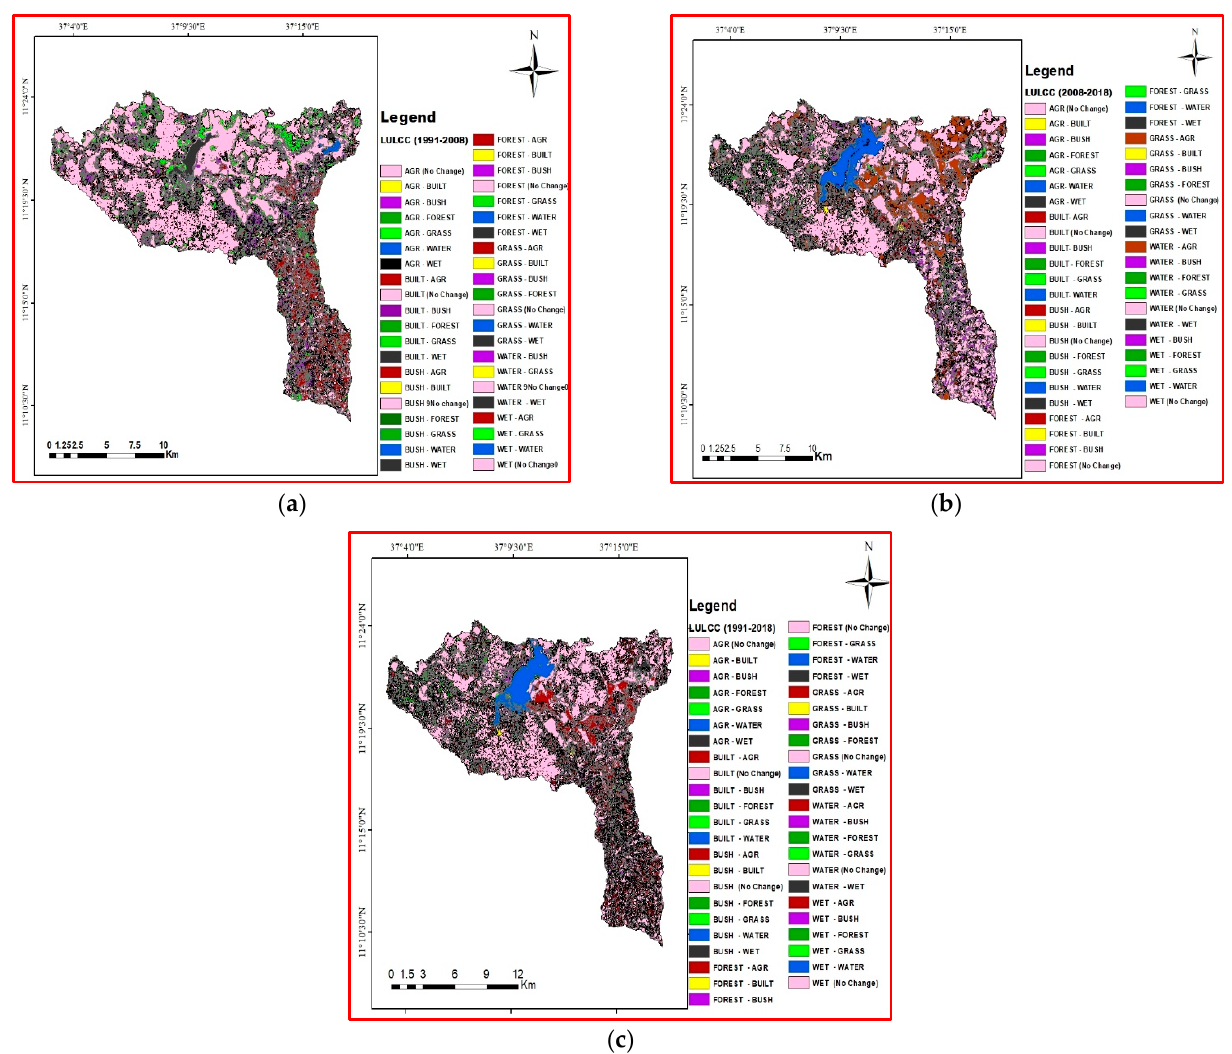
Figure 4. The land use/cover change detection map of (1991–2008) ( a ), (2008–2018) ( b ), and (1991–2018) ( c ).